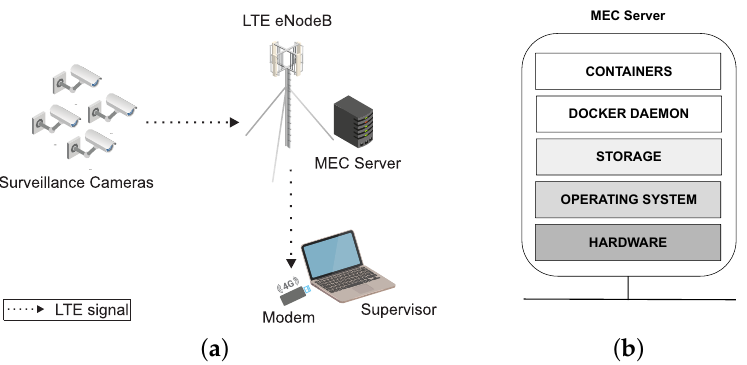
Figure 1. Overview of the evaluated architecture: ( a ) base architecture with all macro elements; and ( b ) layered architecture of the mobile edge computing (MEC)